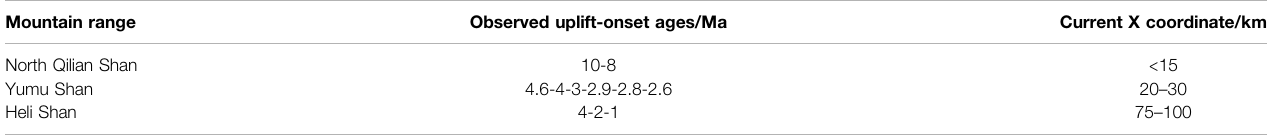
TABLE 1 | Summary of chronological speci fi cations for three mountain ranges of our study. Observations of uplift-start ages and present-day pro fi le horizontal coordinates are shown. Although there are signi fi cant uncertainties (outliers) in ages, a clear uplift-onset migration trend from SWS to NEN exists. Horizontal coordinate as in Figure 1 . See text in this subsection for